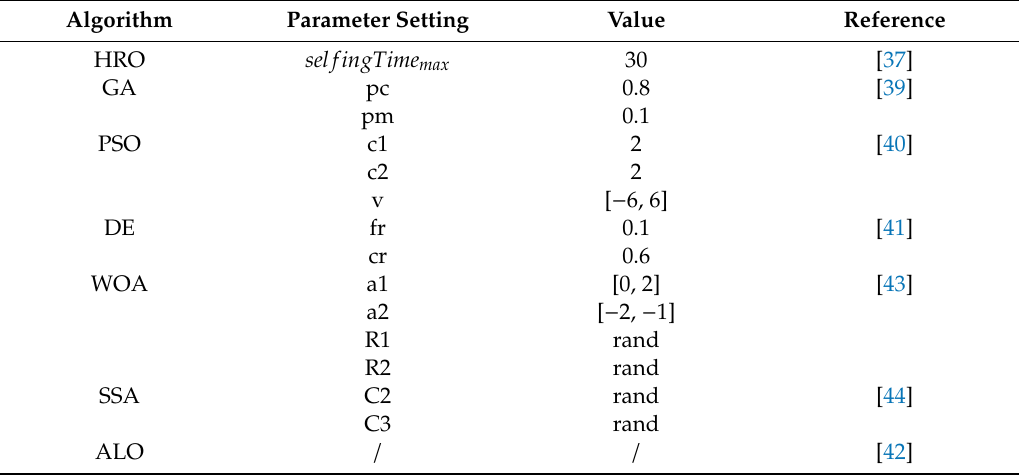
Table 1. Parameter setting of algorithms